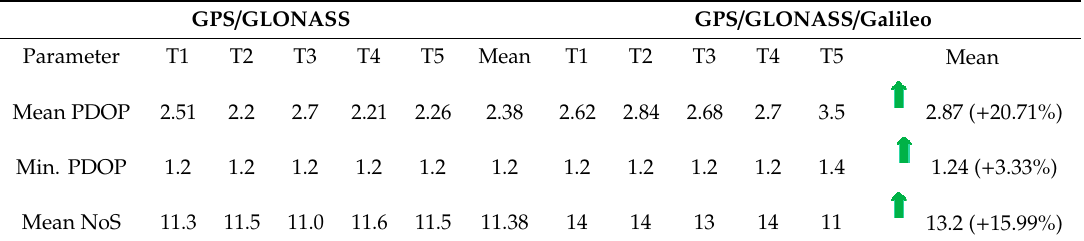
Table 3. The mean and minimum Position Dilution of Precision (PDOP) and the Number of Satellites (NoS) used by the five GNSS geodetic receivers (T1–T5) in measurements during the journeys, with the use of RTK corrections from Global Positioning System (GPS) and GPS/Global Navigation Satellite System (GLONASS) satellites. Table 4. The mean and minimum PDOP and the NoS used by the five GNSS geodetic receivers (T1–T5) in measurements during the journeys, with the use of RTK corrections, from GPS / GLONASS and GPS / GLONASS / Galileo satellites.